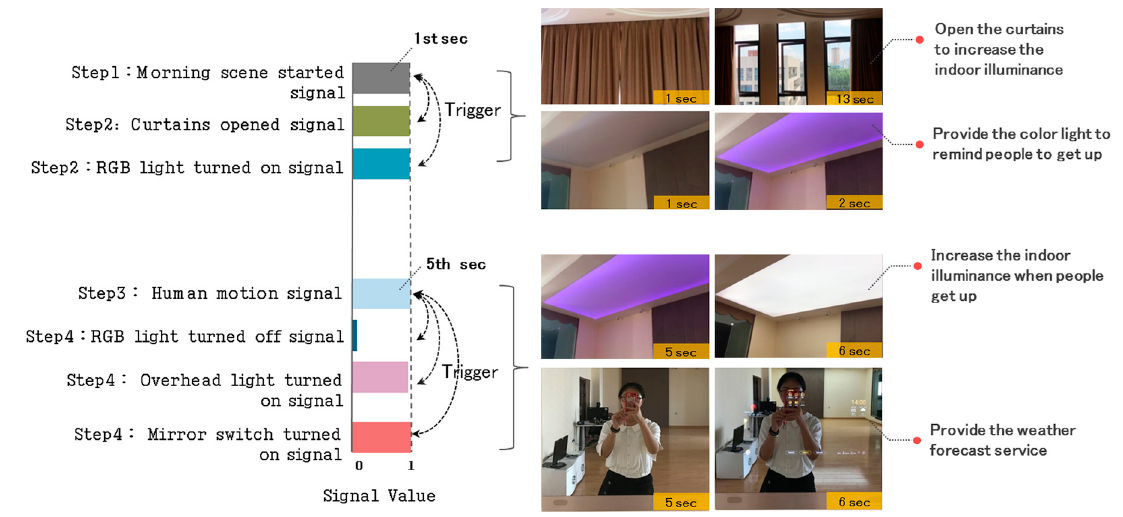
Figure 11. Dynamic control process in the morning scene mode.